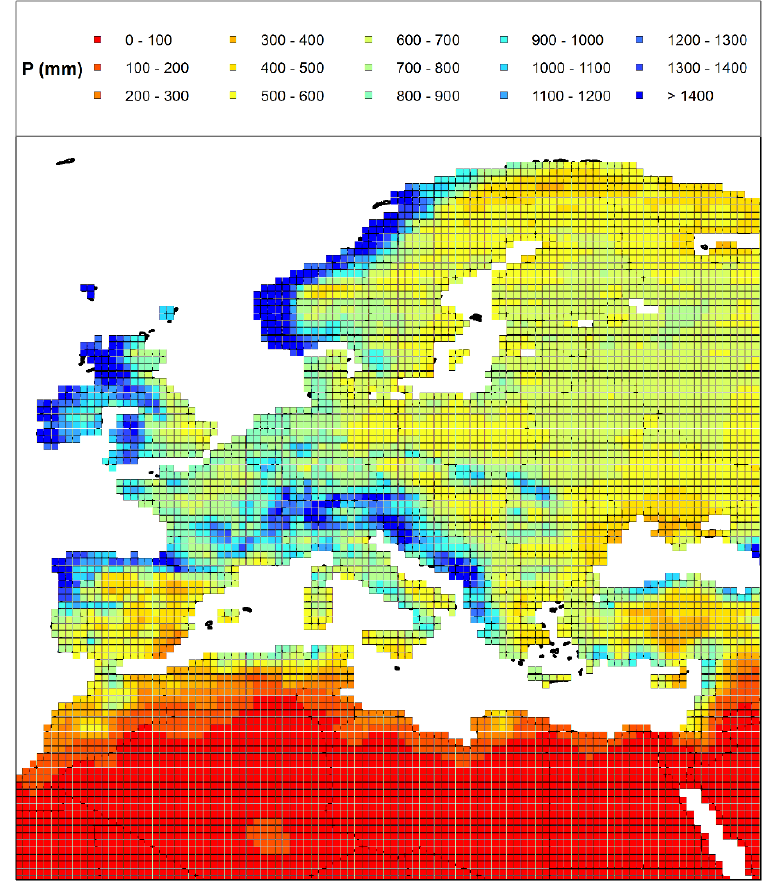
Figure 1. Mean annual rainfall distribution on the study area for the period 1951 – 2016.